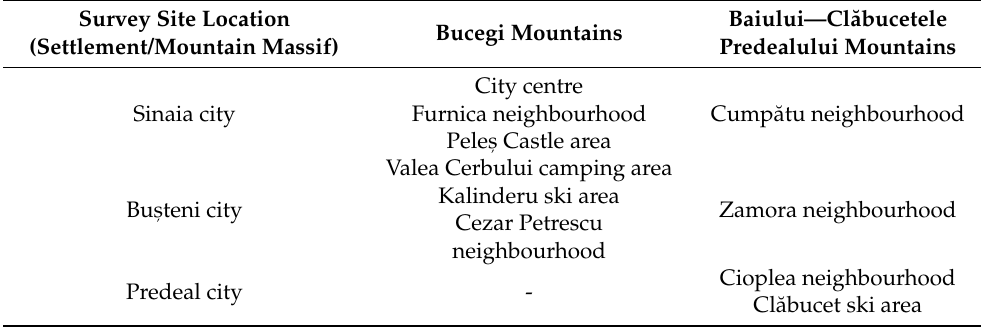
Table A2. The location of survey sites where questionnaires have been applied within settlements and mountain massifs.